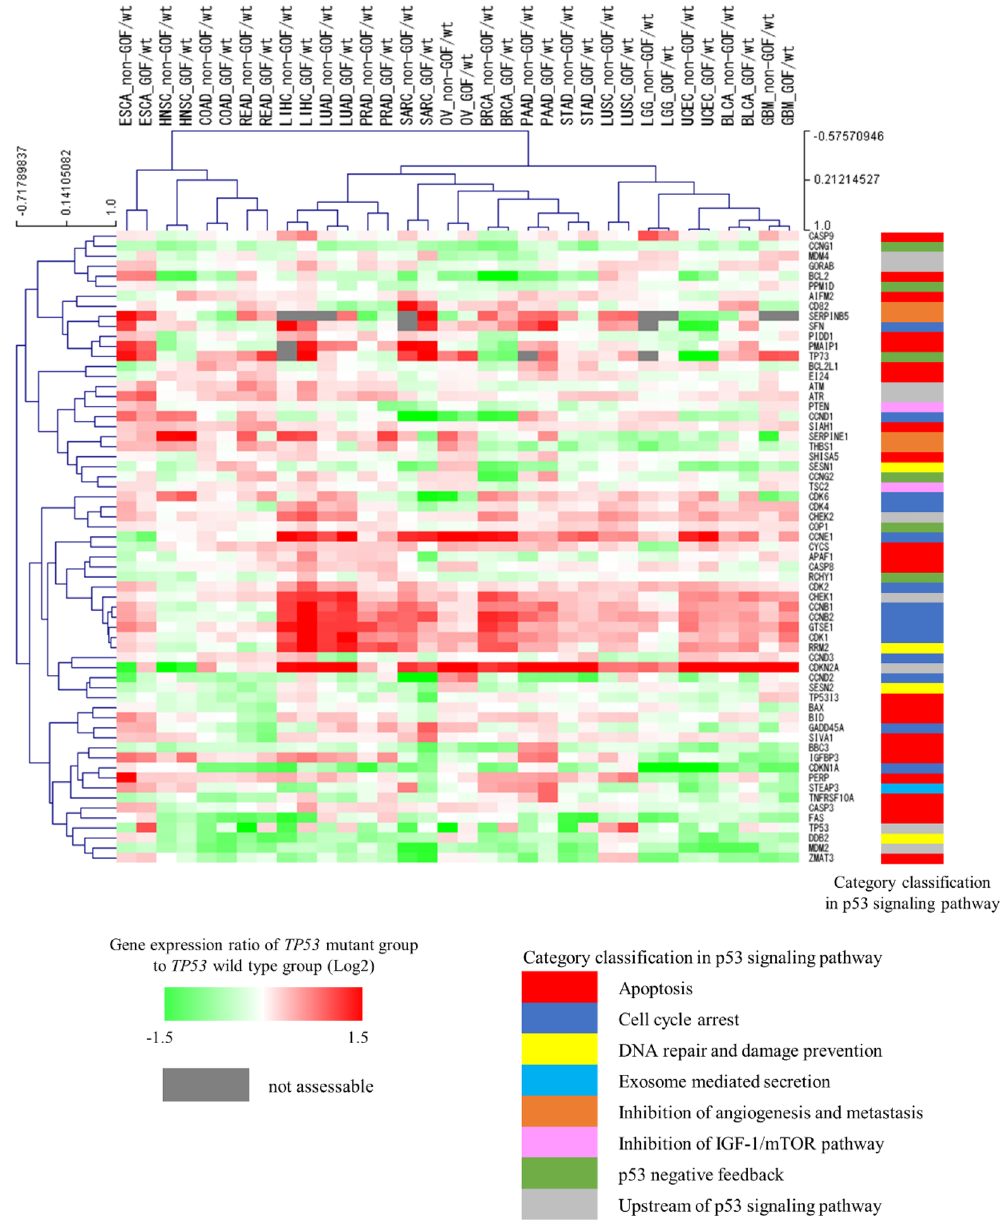
Figure 4. Unsupervised cross-cancer hierarchical clustering. This cluster analysis was performed using the complete linkage method with Pearson correlation distance. BLCA Bladder urothelial carcinoma, BRCA Breast invasive carcinoma, COAD Colon adenocarcinoma, ESCA Esophageal carcinoma, GBM Glioblastoma multiforme, HNSC Head and neck squamous cell carcinoma, LGG Brain lower grade glioma, LIHC Liver hepatocellular carcinoma, LUAD Lung adenocarcinoma, LUSC Lung squamous cell carcinoma, OV Ovarian serous cystadenocarcinoma, PAAD Pancreatic adenocarcinoma, PRAD Prostate adenocarcinoma, READ Rectum adenocarcinoma, SARC Sarcoma, STAD Stomach adenocarcinoma, UCEC Uterine corpus endometrial carcinoma, GOF/wt Gene expression ratio (Log2) of TP53 gain-of-function mutant group to TP53 wild-type group, non-GOF/wt Gene expression ratio (Log2) of TP53 non-gain-of-function mutant group to TP53 wild- type